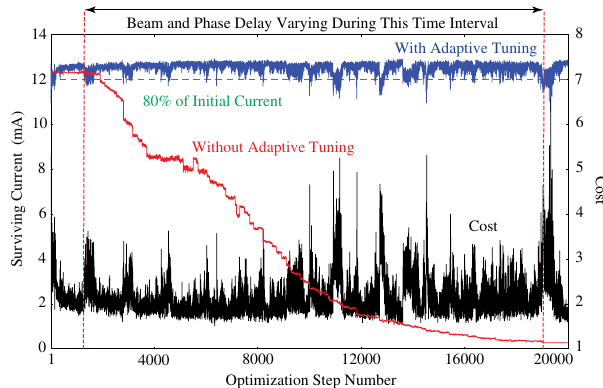
FIG. 17. Surviving beam current at the end of the second DTL tank with and without adaptive RR tuning. The cost evolution during the tuning process is also shown.